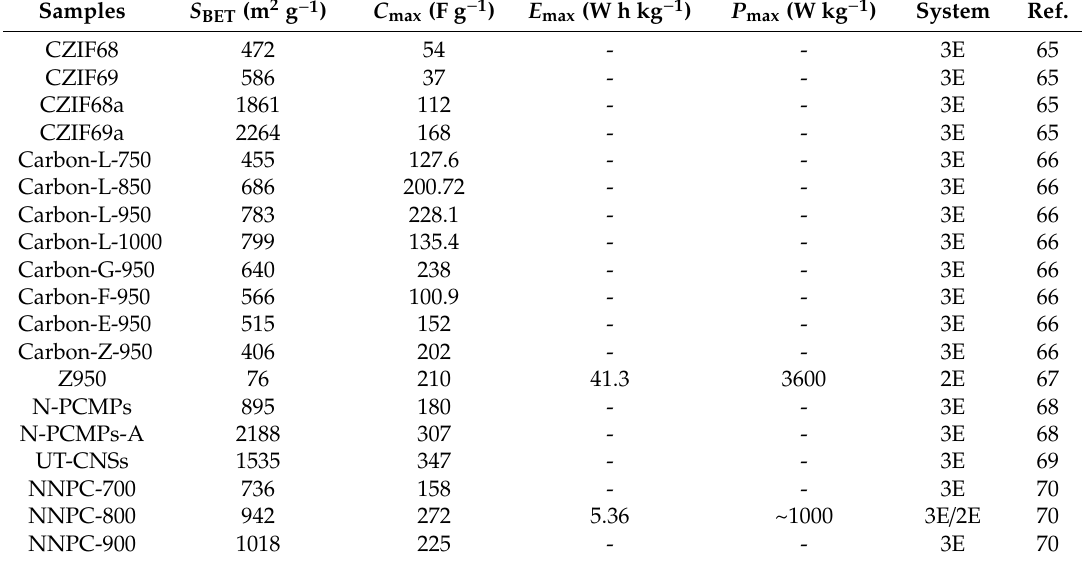
Table 3. The electrochemical capacitive performances of porous carbons derived from other ZIF-based